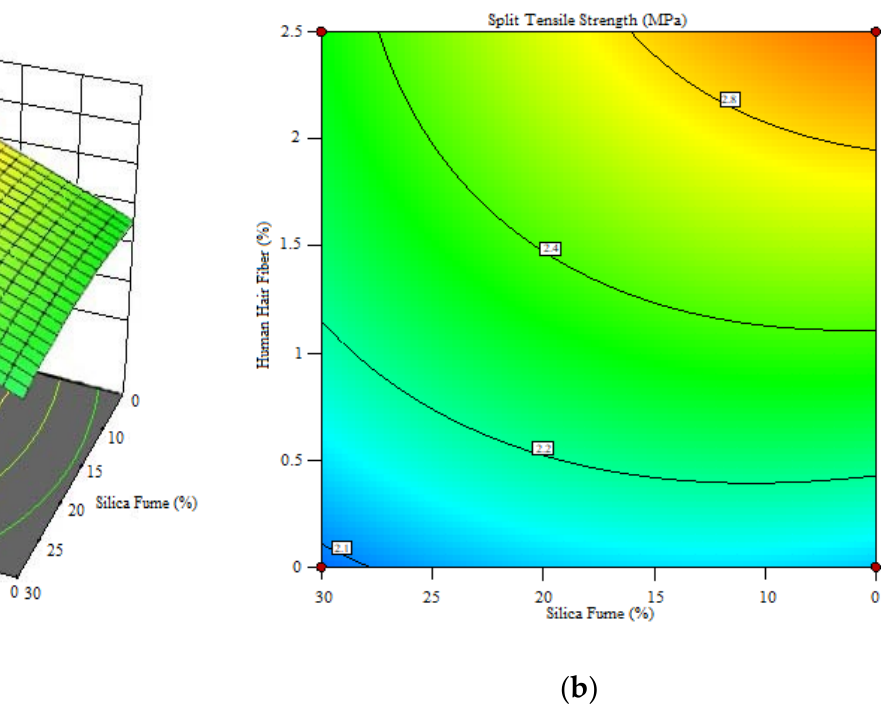
Figure 9. ( a ) 3D surface diagram for split tensile strength; ( b ) 2D contour for split tensile strength.